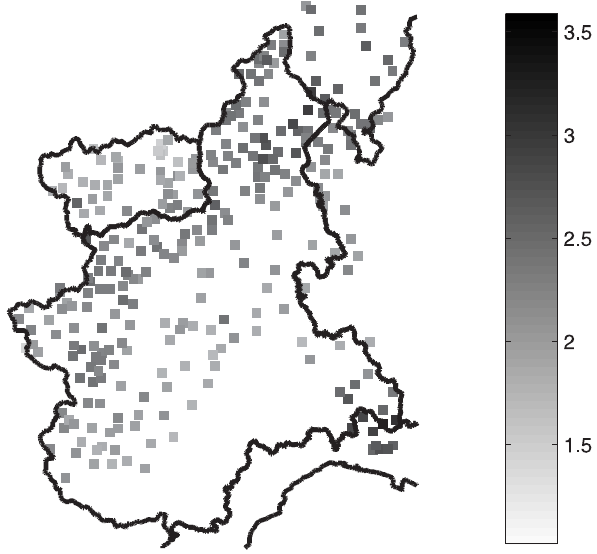
Fig. 6. Return period ratios ( R ( POT ) ) evaluated, for T =100 years, T in 294 rain gauging stations of the North-West of Italy. The color scale refers to the resulting range of variation of R ( POT ) T